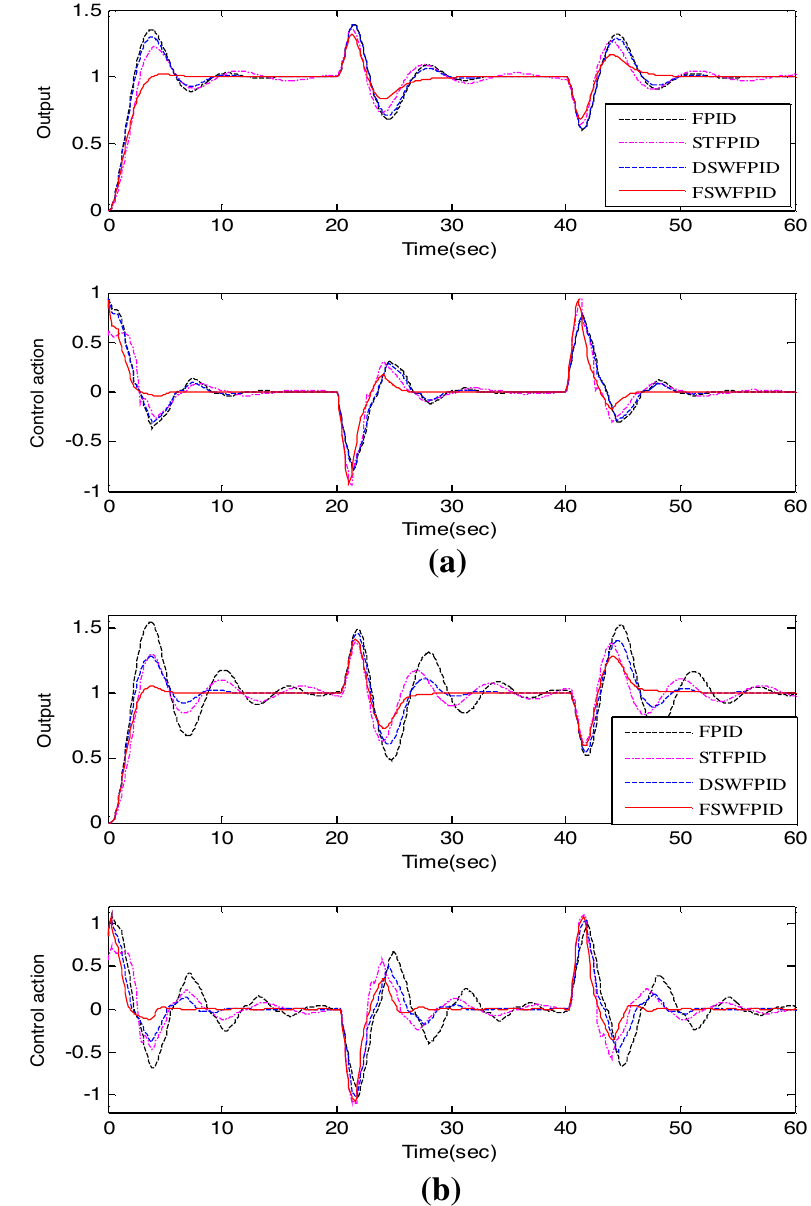
Fig. 6a and b represent the closed-loop responses for L = 0.05 s and L = 0.3 s with 25 control rules. Tables 4 and 5 contain the performance indices in terms of percentage t t overshoot (%OS), rise time , settling time , integral r ) s ) ( ( absolute error (IAE), integral time absolute error (ITAE) and total variantion in control action (TV) during closed-loop operation with 49 and 25 control rules, respectively. From the responses (Fig. 5a, b) and the listed performance indi- ces (Table 4) it is found that overshoot has been entirely eliminated in case of our proposed FSWFPID with 49